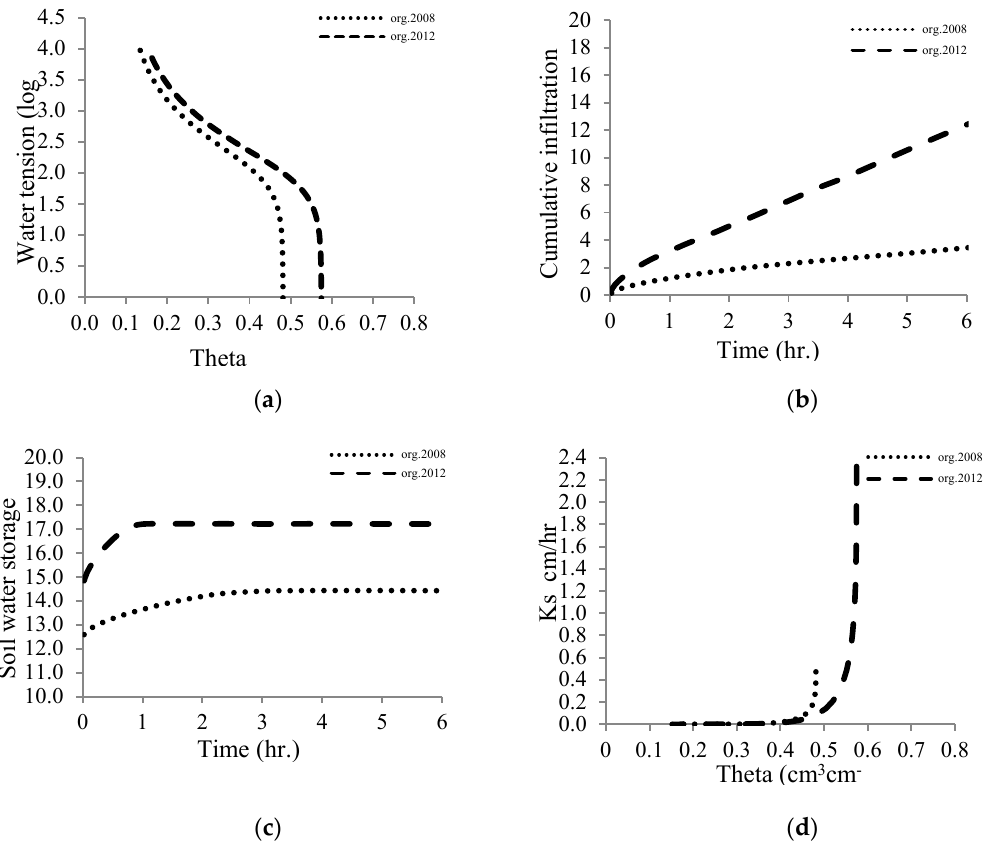
Figure 5. Hydraulic properties under organic management, ( a ) water retention curves, ( b ) cumu- lative infiltration versus time, ( c ) soil water storage capacity versus time, ( d ) saturated hydraulic conductivity versus volumetric water content.